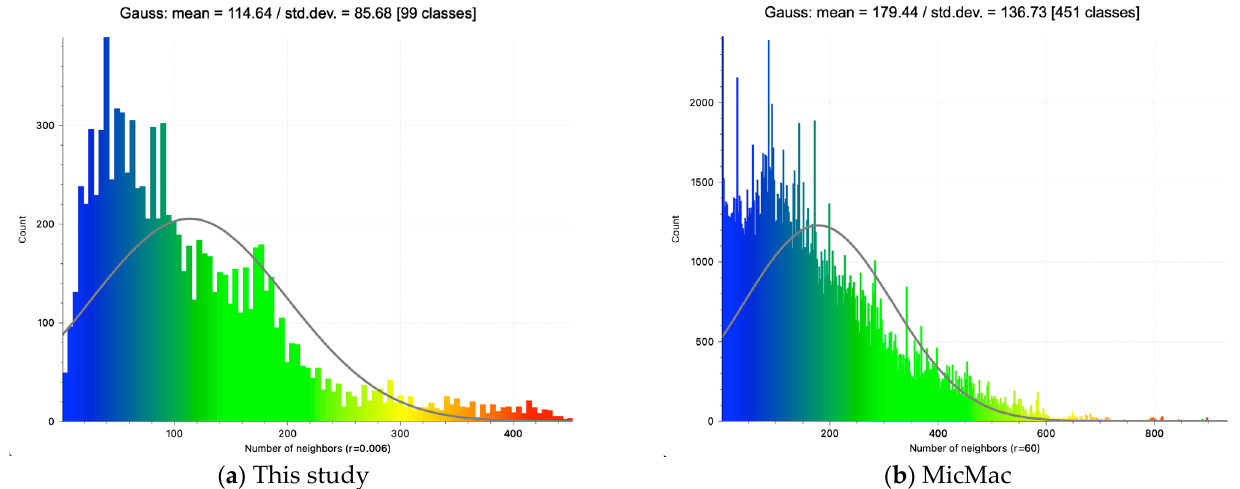
Figure 17. Histogram of the density evaluation of a bigger shift on the reconstruction in CloudCompare.